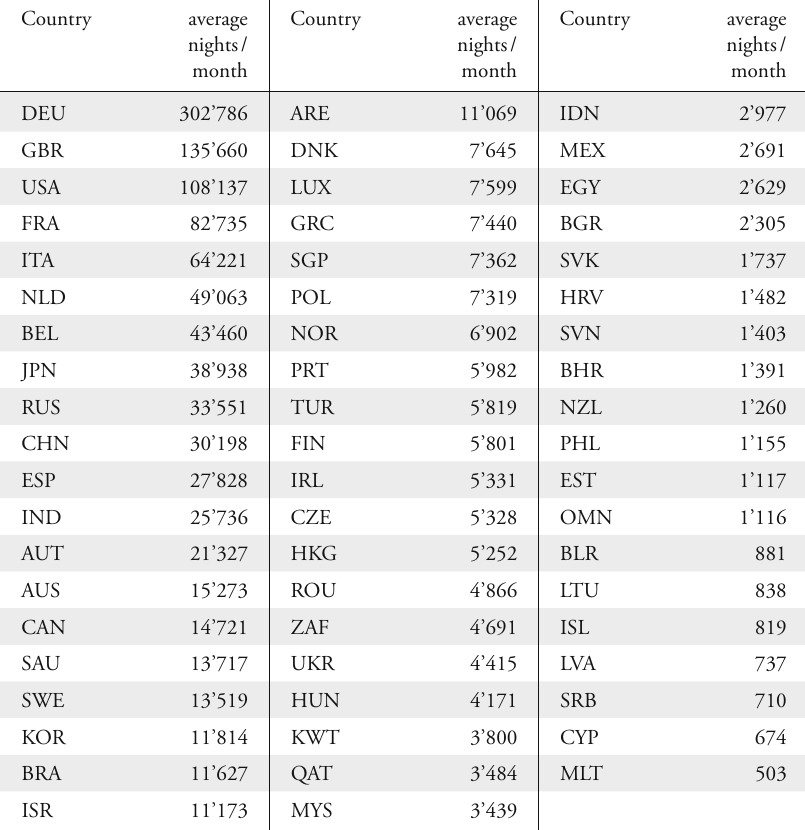
ISR Source: FSO; Averages are taken over the 10-year period from January 2005 to December 2014, except AUS, CYP, EST, LTU, LVA, MLT, and NZL (average over period from January 2010 to December 2015) and ARE, BHR, KWT, MEX, OMN, QAT, and SAU (January 2011 to Decem- ber